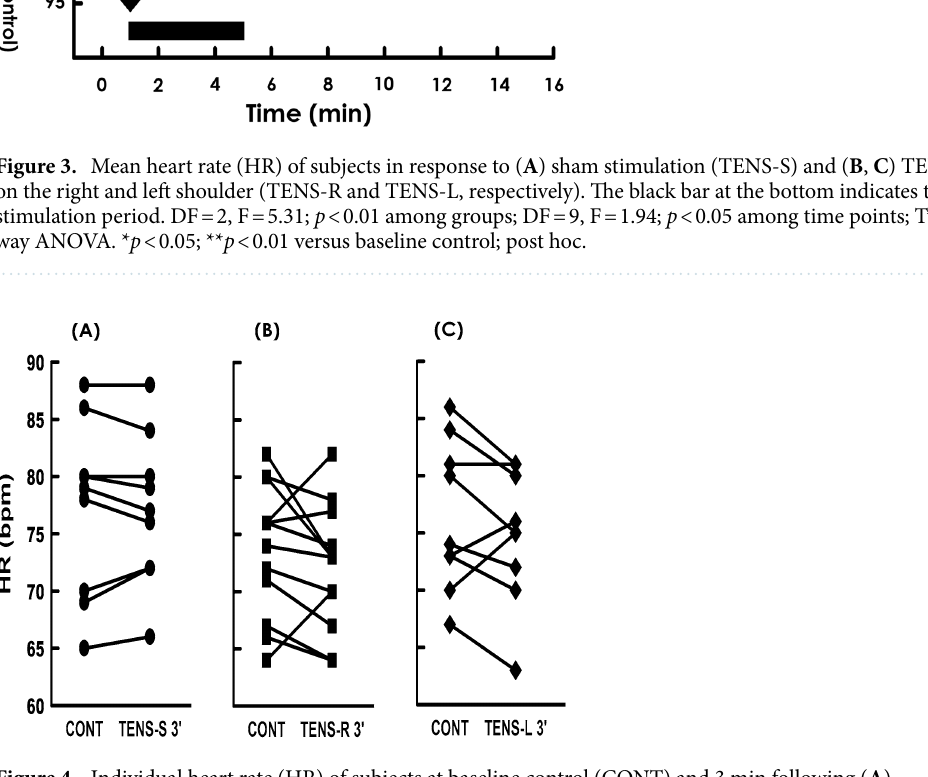
to the left trunk of the vagus nerve, right-sided stimulation provokes a greater bradycardic effect in canines 11 . In healthy subjects stimulated with a transcutaneous unit 12 and heart failure patients stimulated with an implanted device 8 , applying current to the right vagus nerve induces a more pronounced HR decrement than to the left. Analogously with these studies, our results demonstrated TENS-R and TENS-L with identical parameters syn- ergistically but asymmetrically modified HR, i.e., TENS-R induced a sustained but TENS-L did a transient effect